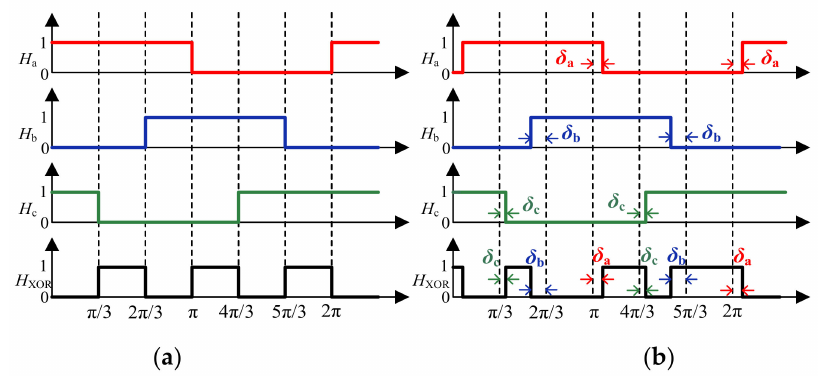
Figure 9. ( a ) Ideal Hall signals; ( b ) Hall signals with deviation.